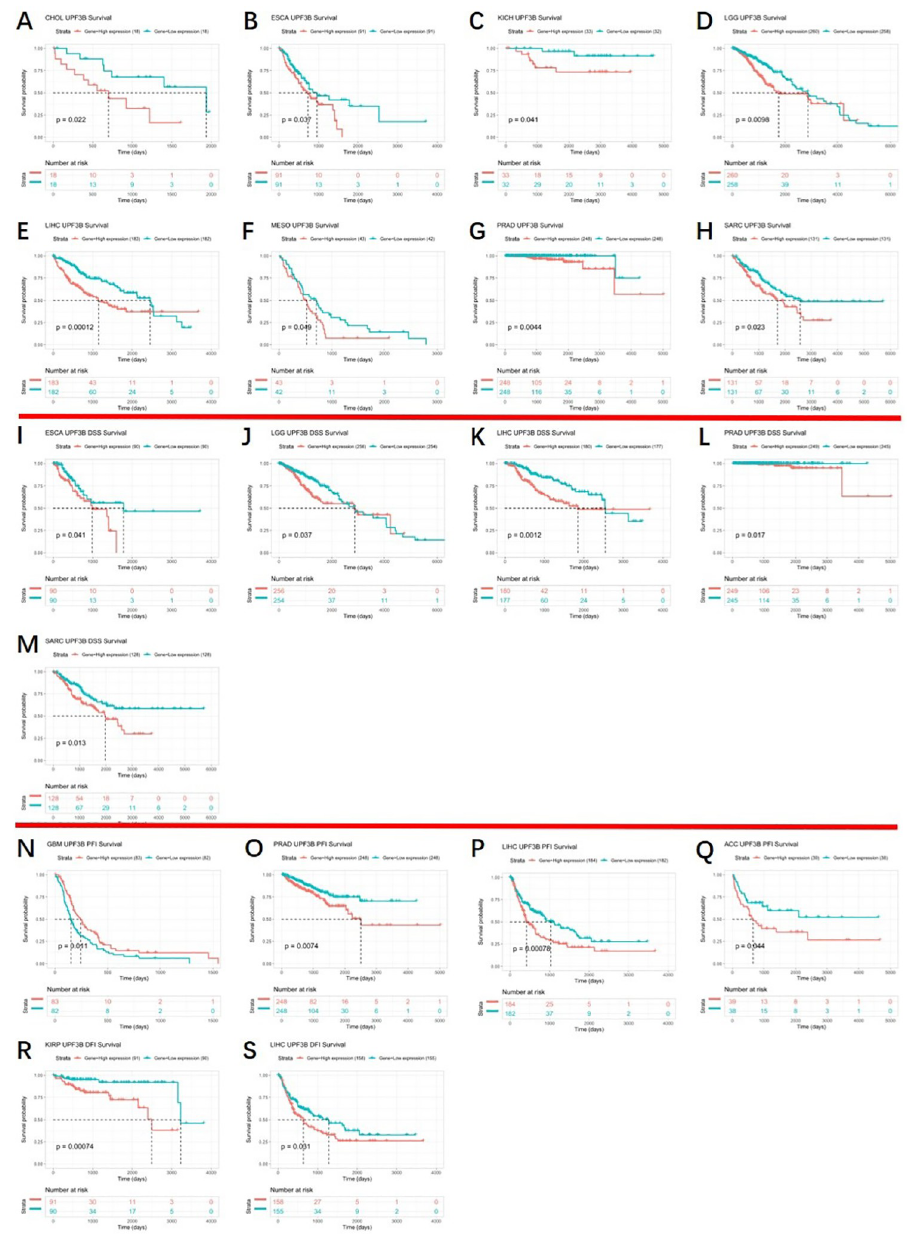
Fig 4. Kaplan–Meier analysis of patient prognosis in 33 TCGA tumor types, group division was based on the median of UPF3B expression. (A-H) Association between UPF3B expression and OS of cancer patients. (I-M) Correlations of UPF3B expression with DSS of patients. (N-Q) Correlations of UPF3B expression with PFI of patients. (R, S) Correlations of UPF3B expression with DFI of patients. Data was obtained via TCGA. � p < 0.05, �� p < 0.01, ��� p < 0.001, ���� p <